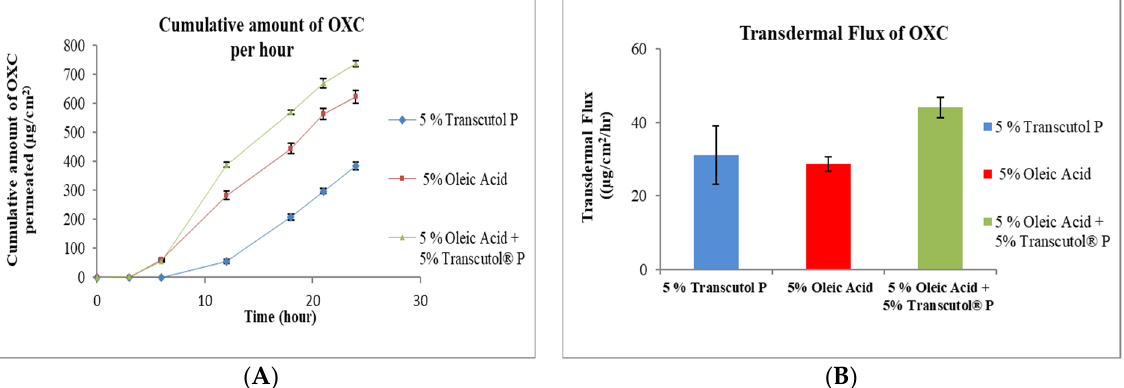
Figure 5. In vitro cumulative amount of OXC permeated per unit area versus time ( A ) and transdermal flux of OXC ( B ) across the human cadaver skin in presence or absence of the combination of Transcutol ® P and oleic acid. Each point represents the mean ± S.D. of three replicates in the absence of multiple donors.